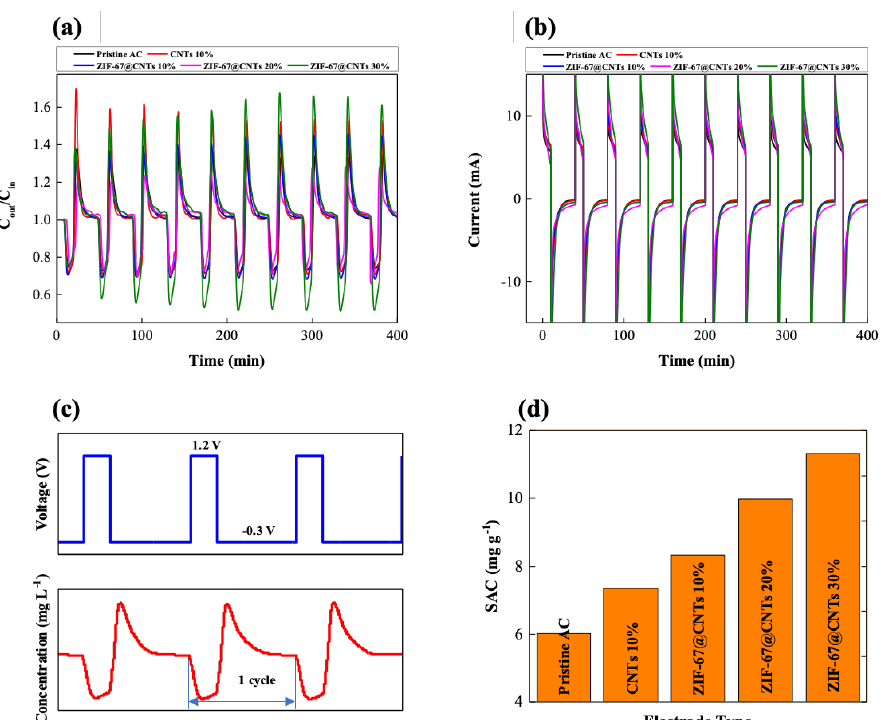
Figure 5. Variation in the ( a ) salt concentration of effluent stream and ( b ) measured current during CDI desalination for 10 cycles. ( c ) Potential difference applied to CDI cell ( top ) and change in effluent concentration magnified from ( a ) ( bottom ). ( d ) Calculated salt adsorption capacity of various CDI electrodes.